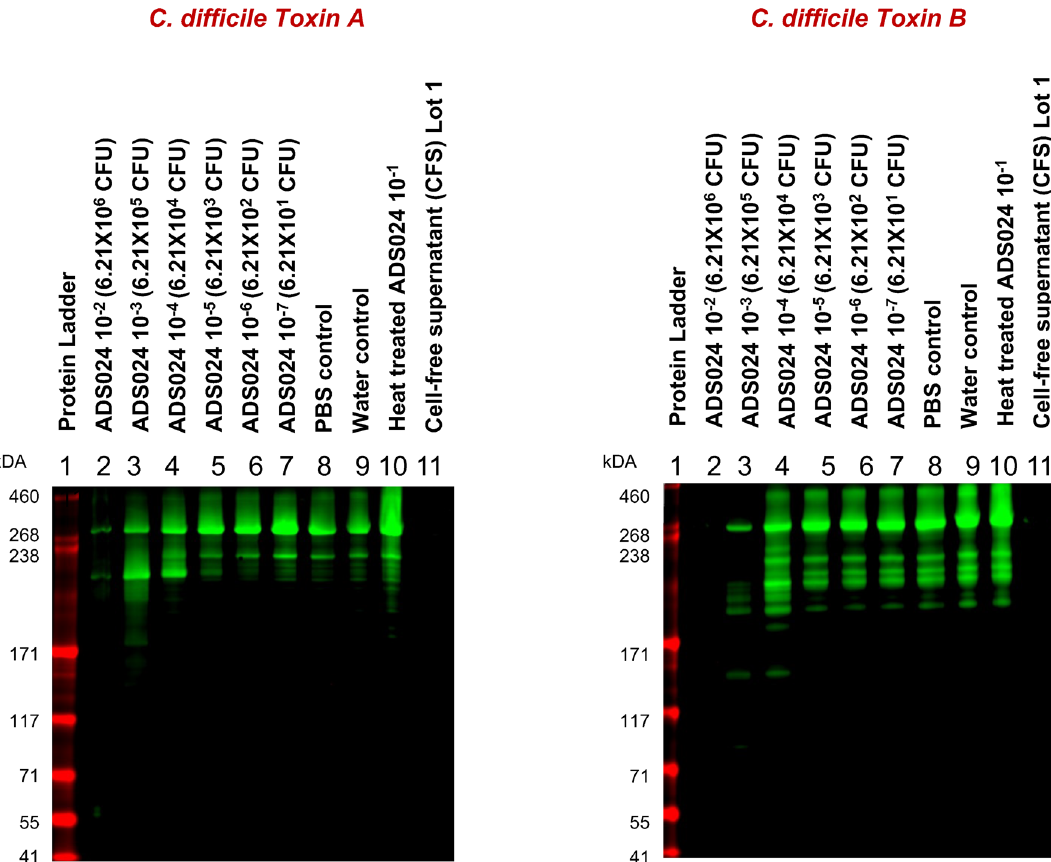
Figure 6. ADS024 CFS, and lyophilate degrade C. difficile toxin A and toxin B. Lane 1 shows a Novex Hi Mark pre-stained protein ladder. Toxin A (left) and toxin B (right) were incubated with reconstituted lyophilized ADS024 (lanes 2–7), or CFS (lane 11) in the amounts shown, and toxin proteolytic cleavage was detected by western blot to toxin A and toxin B, respectively. Reconstituted lyophilate was tested once using duplicate samples. Lane 12 and lane 13 use a CFS of Lot 2 and Lot 3, respectively. Images were captured with a Licor Odyssey gel imager. See full uncropped image of Lanes 1–13 in Supplementary Fig. 1 in the supplemental